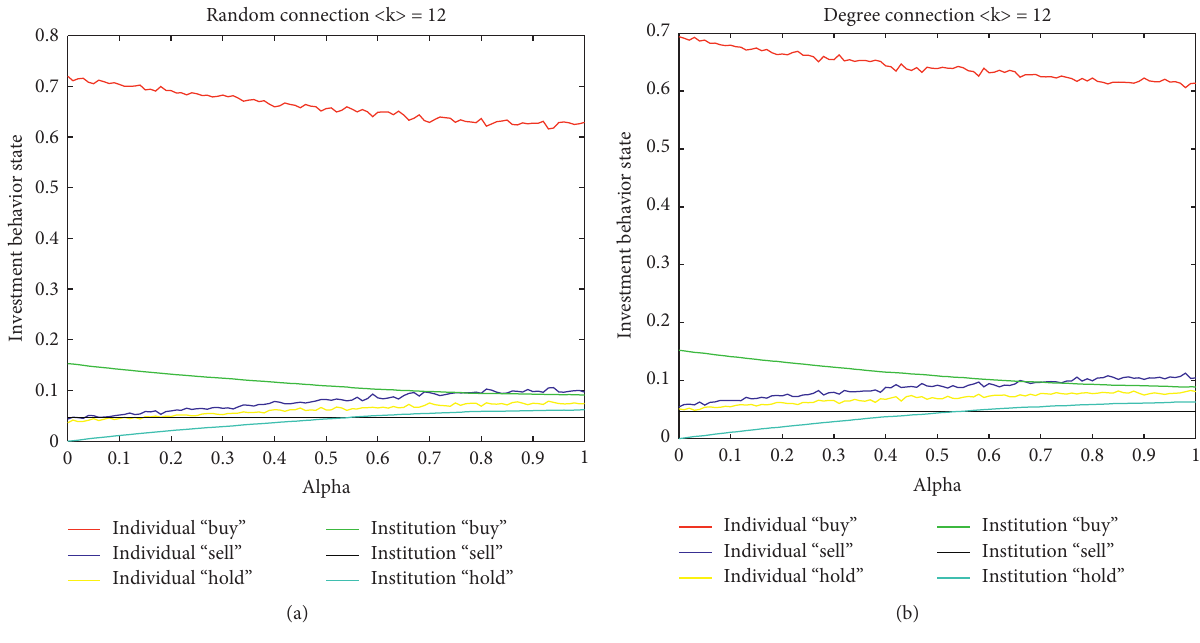
Figure 3: The impact of α on the evolution of investor behavior.